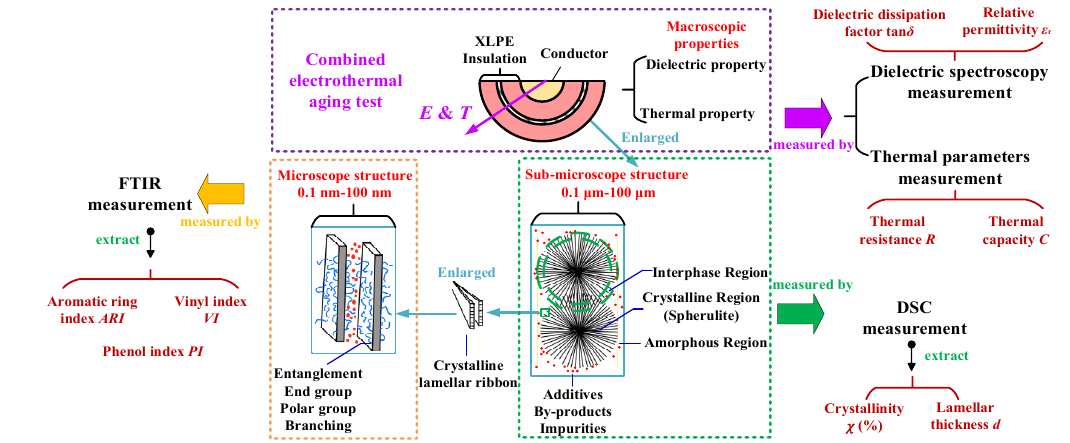
Figure 10. The logic diagram of the integral structure layout.